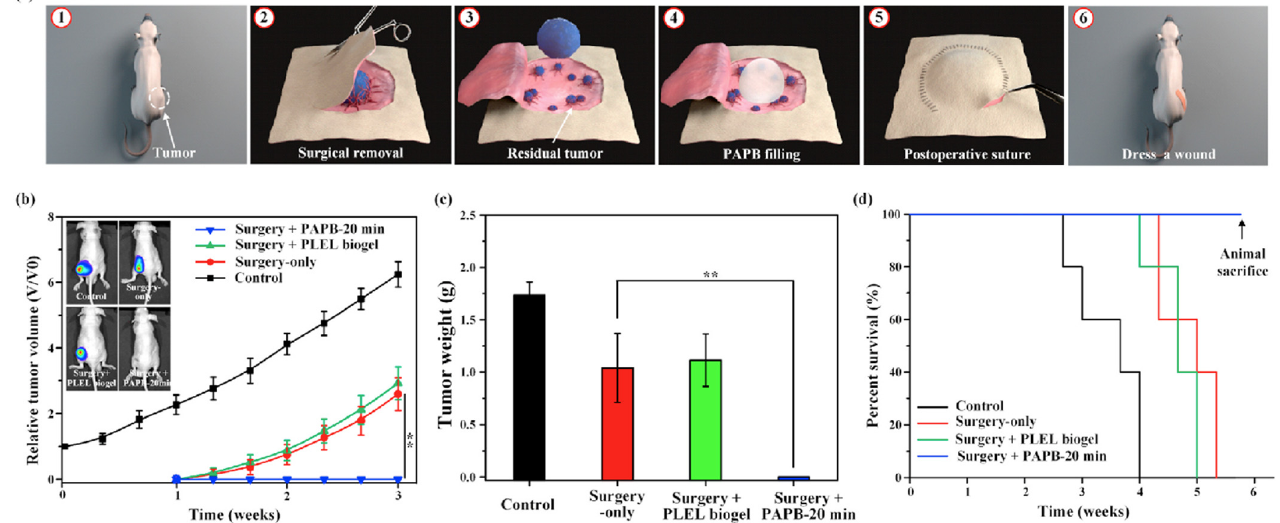
Figure 3. Anti-tumor performance of a plasma-activated PLEL biogel (PAPB) on residual tumor after surgical removal. ( a ) Schematic illustration of post-operative PAPB treatment. ( b ) Whole-body bioluminescence imaging and tumor growth in mice: control, surgical removal-only, surgical removal + PLEL (thermosensitive biogel), and surgical removal + PAPB treatment. ( c ) Weight of excised tumors. ( d ) Survival of tumor-bearing mice ( n = 5, ** p < 0.01). Reprinted with permission from Ref. [88]. 2021, Elsevier Ltd.